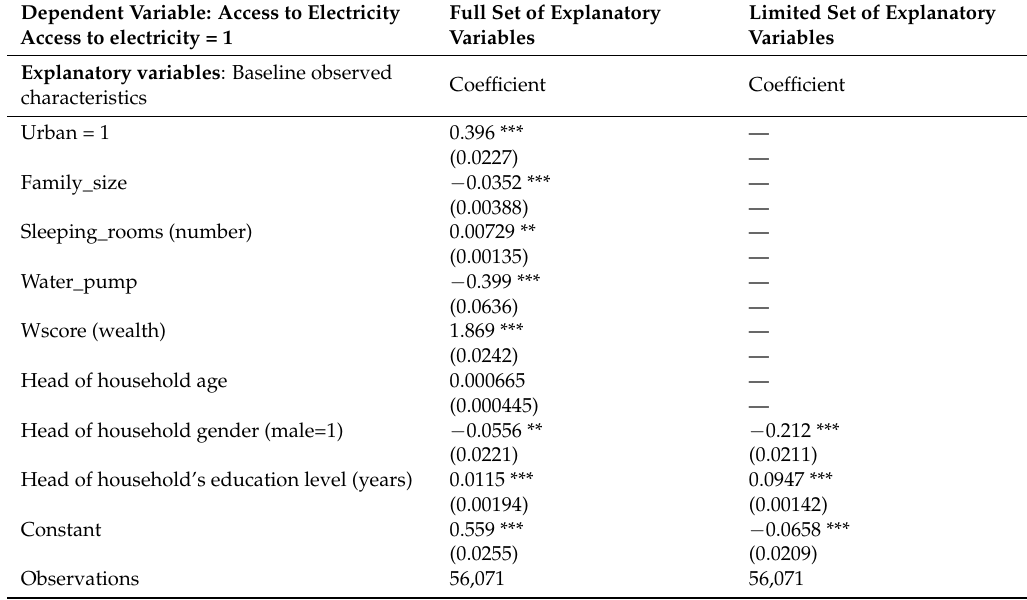
Table 2. Probit regression: estimating the propensity score based on baseline observed